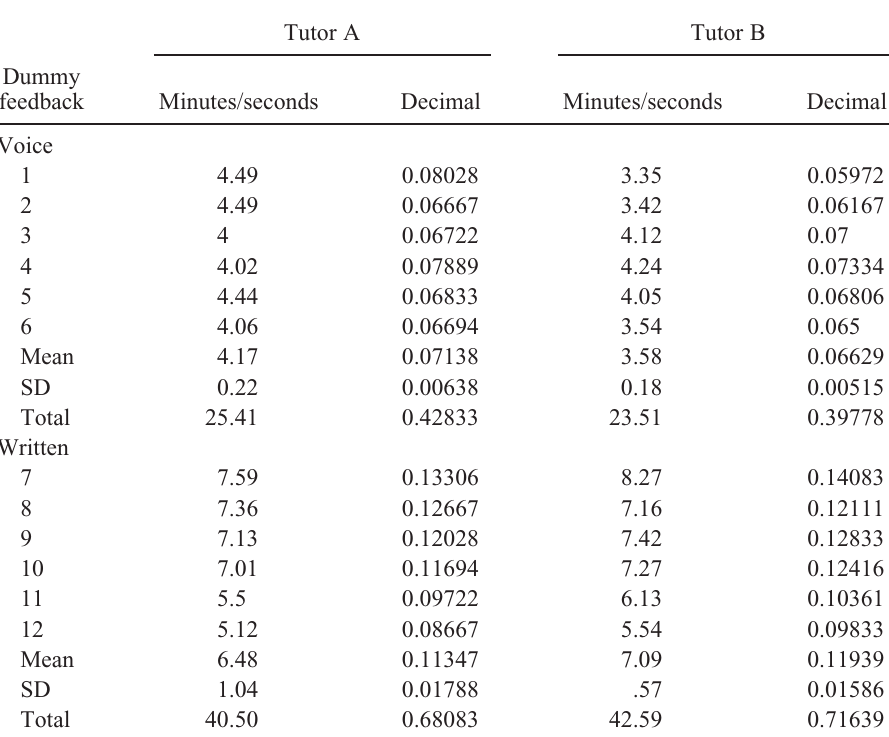
Table 8. Benchmark timings for delivery of ‘dummy’ audio and written feedback.